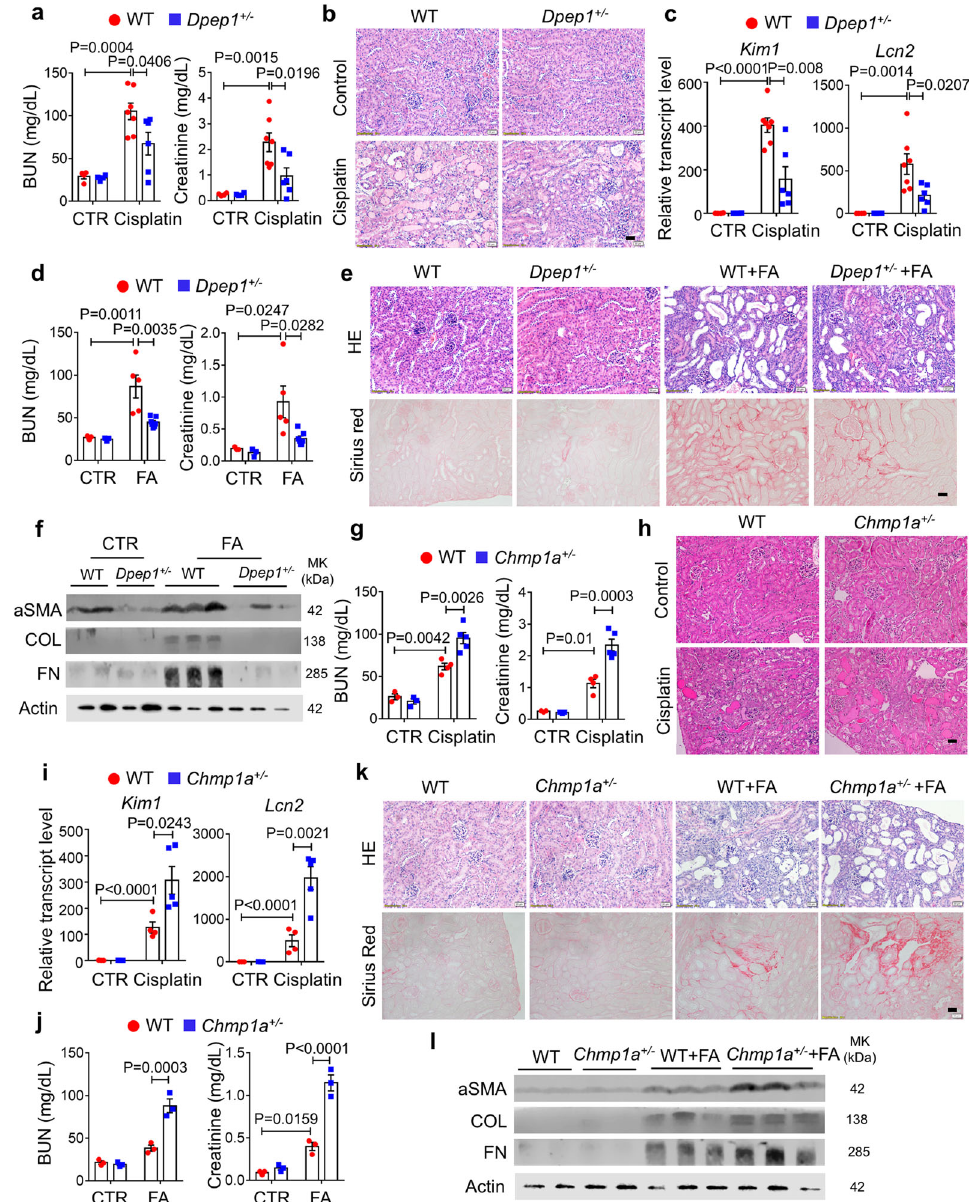
Fig. 3 Dpep1 de fi ciency ameliorated but Chmp1a haploinsuf fi ciency exacerbated renal injury in mice. a Serum blood urea nitrogen (BUN) and creatinine measurement of control and Dpep1 + / − mice following sham or cisplatin injection. Sham-treated group: WT ( n = 4), Dpep1 + / − ( n = 4); cisplatin-treated group: WT ( n = 7), Dpep1 + / − ( n = 6). b Representative images of HE-stained kidney sections from control and Dpep1 + / − mice following sham or cisplatin injection. Scale bar: 20 μ m. c Relative mRNA level of injury markers Kim1 and Lcn2 in the kidneys of control and Dpep1 + / − mice following sham or cisplatin injection. Sham-treated group: WT ( n = 4), Dpep1 + / − ( n = 4); cisplatin-treated group: WT ( n = 7), Dpep1 + / − ( n = 6). d Serum BUN and creatinine measurement of control and Dpep1 + / − mice following sham or folic acid (FA) injection. Sham-treated group: WT ( n = 3), Dpep1 + / − ( n = 3); cisplatin- treated group: WT ( n = 5), Dpep1 + / − ( n = 7). e Representative images of HE- and Sirius Red-stained kidney sections from control and Dpep1 + / − mice following sham or FA injection. Scale bar: 20 μ m. f Western blots of fi brosis markers aSMA, Collagen3, and Fibronectin in kidneys of control and Dpep1 + / − mice following sham or FA injection. g Serum BUN and creatinine measurement of control and Chmp1a + / − mice following sham or cisplatin injection. Sham-treated group: WT ( n = 3), Dpep1 + / − ( n = 3); cisplatin-treated group: WT ( n = 4), Dpep1 + / − ( n = 5). h Representative images of HE-stained kidney sections from control and Chmp1a + / − mice following sham or cisplatin injection. Scale bar: 20 μ m. i Relative transcript level of injury markers Kim1 and Lcn2 in control and Chmp1a + / − mice following sham or cisplatin injection. Sham-treated group: WT ( n = 3), Dpep1 + / − ( n = 3); cisplatin-treated group: WT ( n = 4), Dpep1 + / − ( n = 5). j Serum BUN and creatinine levels of control and Chmp1a + / − mice following sham or FA injection ( n = 3 per group). k Representative images of HE- and Sirius Red-stained kidney sections from control and Chmp1a + / − mice following sham or FA injection. Scale bar: 20 μ m. l Western blots of fi brosis markers aSMA, Collagen3, and Fibronectin in control and Chmp1a + / − mice following sham or FA injection. All data are represented as mean ± SEM. P value was calculated by two-way ANOVA with post hoc Tukey test. P < 0.05 is statistically signi fi cant. A Source Data fi le is available for this fi